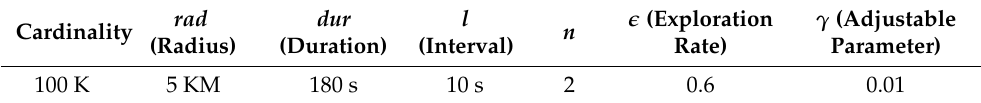
Table 3. Setting of synthetic data parameters and algorithm parameters in concept drift experiment.